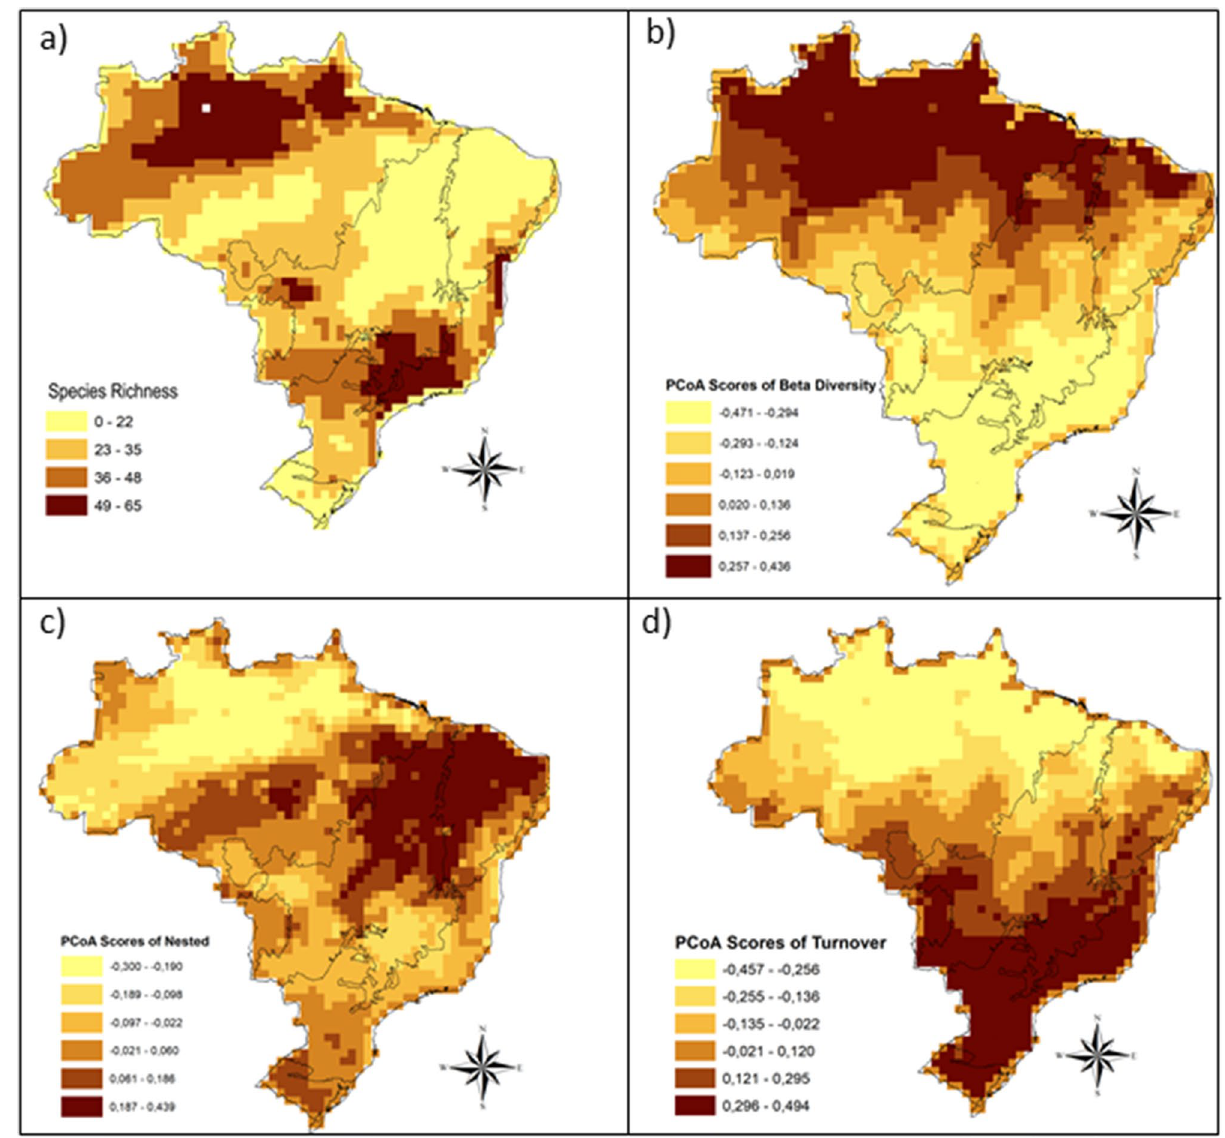
Figure 2. Predicted spatial distributions, based on species predicted presences resulting from the binarization of MaxEnt output of ( a ) richness, ( b ) total beta diversity, ( c ) turnover and ( d ) nestedness of Gerromorpha in Brazil. The figure was built on the R environment 63 .